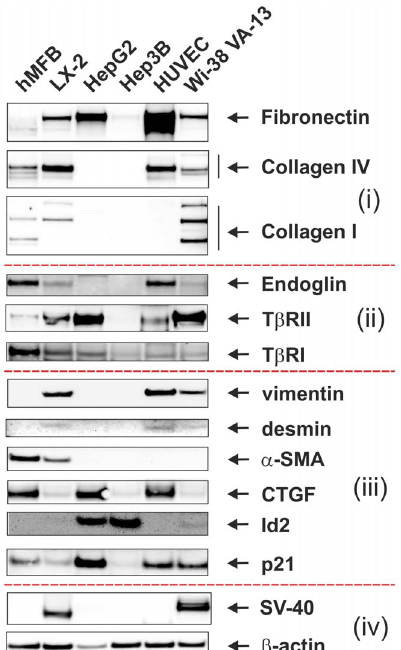
Figure 1. Expression analysis. Cell extracts were prepared from hMFB, LX-2, HepG2, Hep3B, HUVEC and Wi-38 VA-13 subline 2RA and analysed in Western blot for expression of (i) extracellular matrix proteins (fibronectin, collagen IV, collagen I), (ii) receptors of TGF- b (endoglin, T b RII, T b RI), (iii) HSC/MFB markers (vimentin, desmin, a -SMA, CTGF, Id2, p21), and (iv) SV40 large T-antigen and b -actin. We used two parenchymatic (HepG2, Hep3B) and other cell entities (hMFB, HUVEC, and WI-38) as controls because they are well characterized for the expression of tested genes and served as positive or negative controls in this